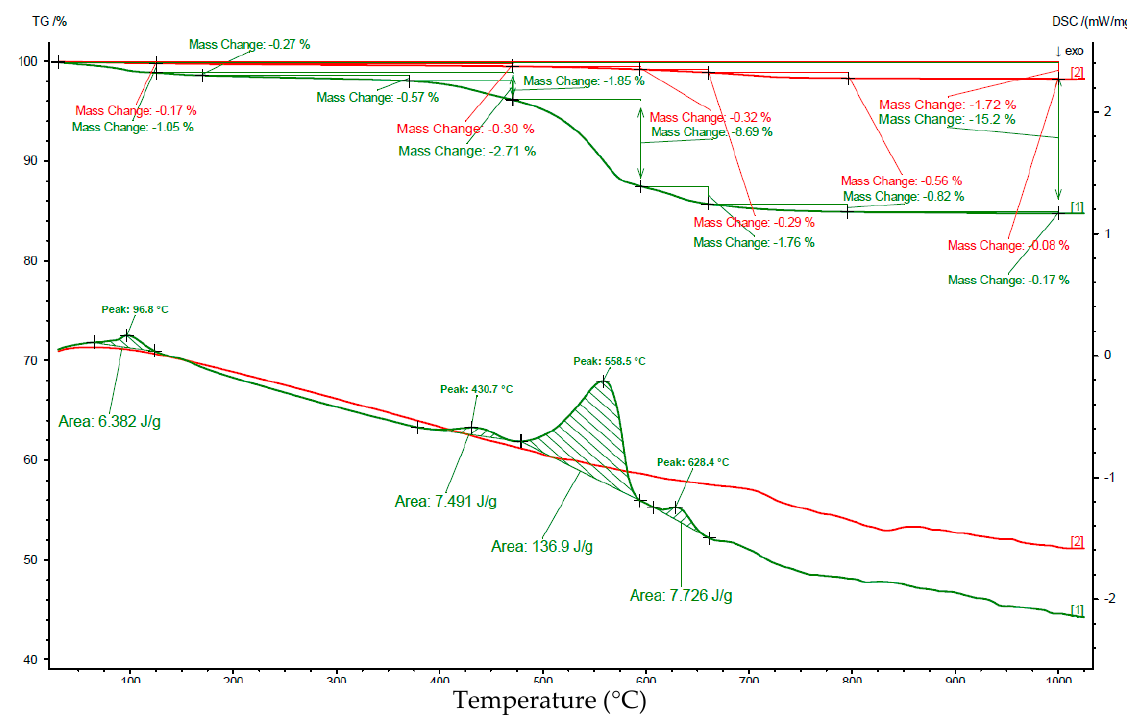
Figure 9. TGA/DSC Analysis in Exp. 3 in the presence of additives.